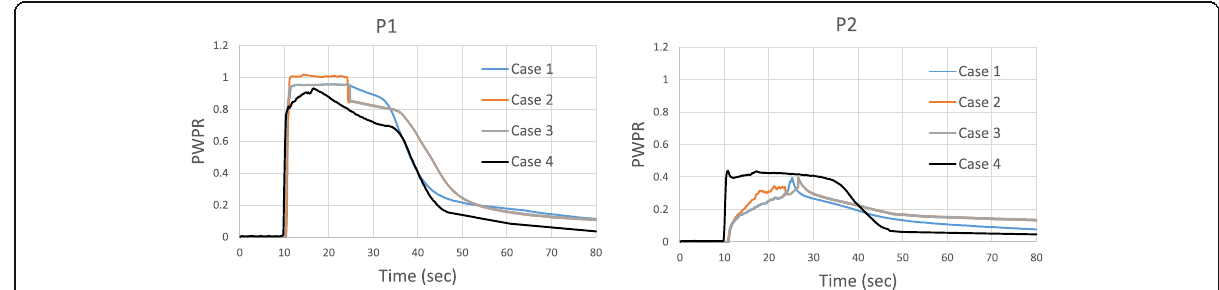
Fig. 7 Pore water pressure ratio time histories